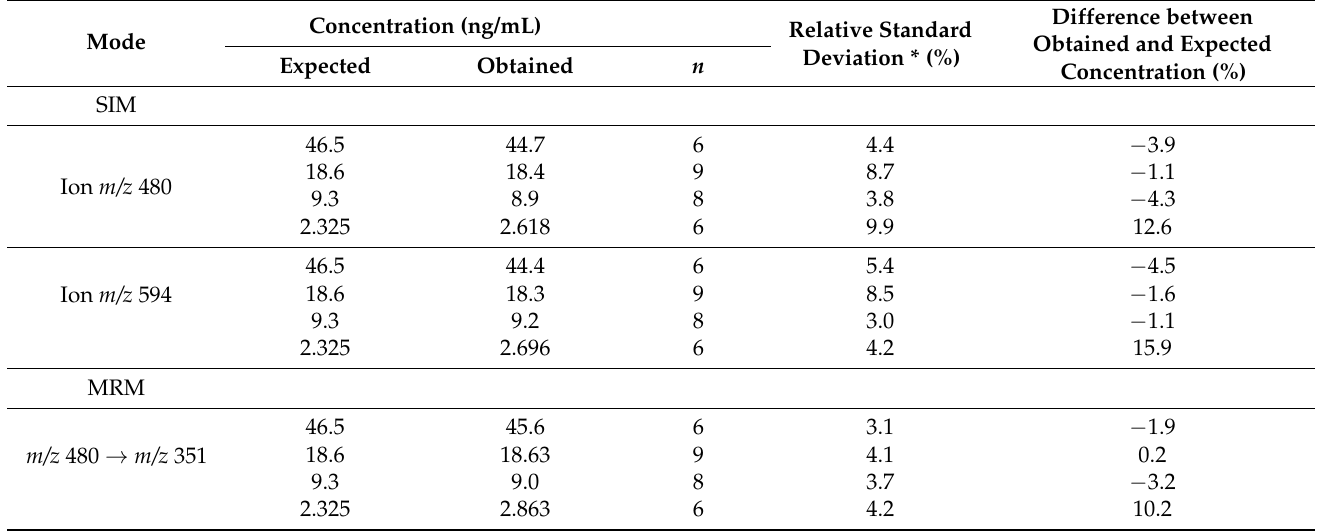
Table 3. Reproducibility in SIM and MRM modes tested using different concentrations of